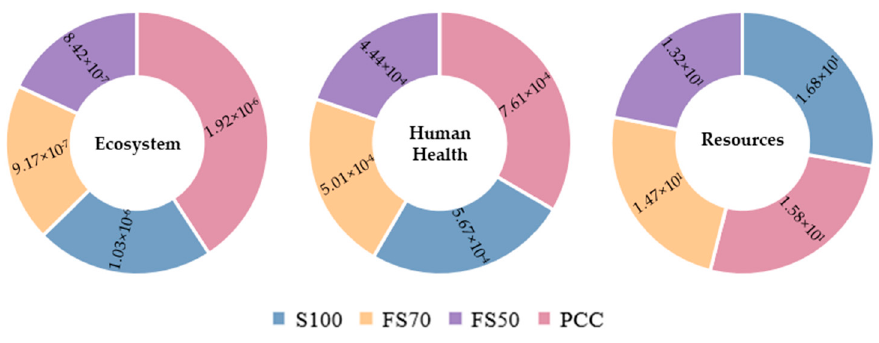
Figure 6. Endpoint impacts of AAC and PC concrete.